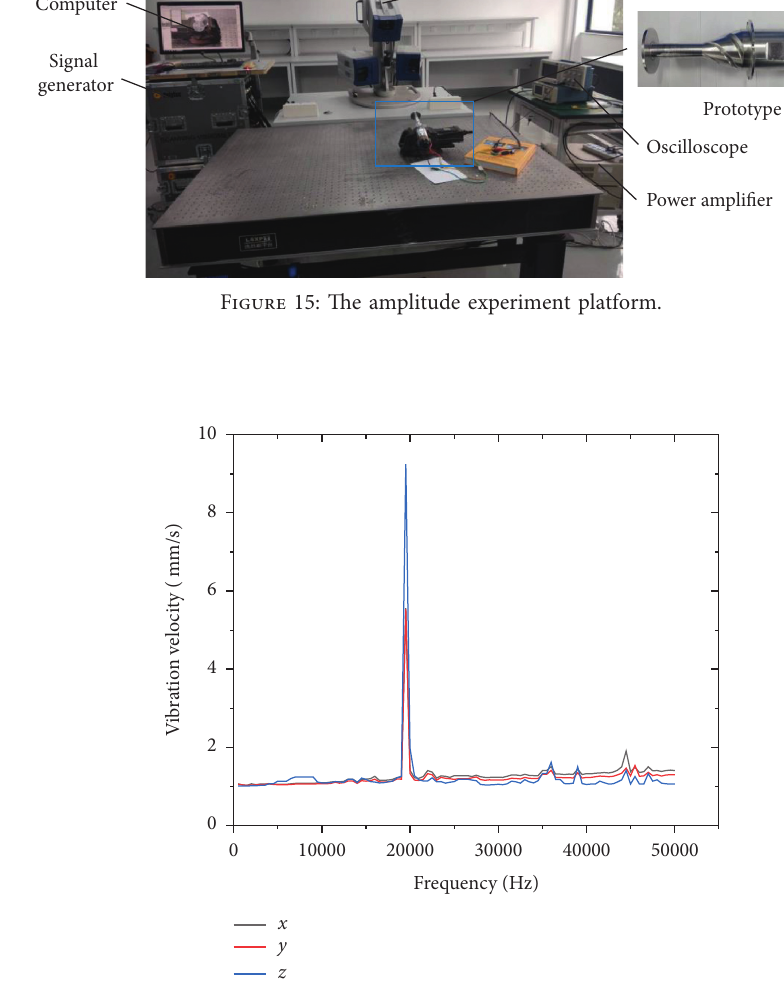
Figure 16: Frequency-scanning results of the consolidation vibration system.